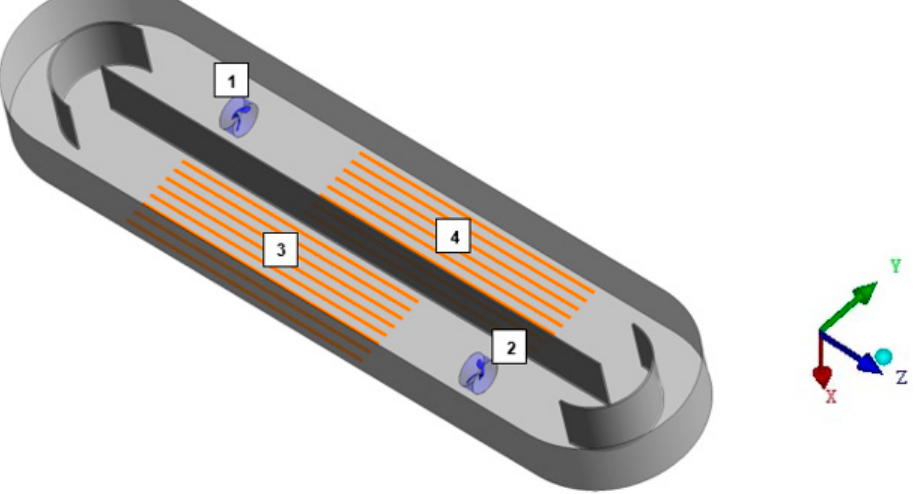
Figure 2. 3D view of the full-scale oxidation ditch, agitators (1 and 2), diffuser grids (3 and 4). There are two aeration channels, and each of them is partially covered with a diffuser grid. Fine